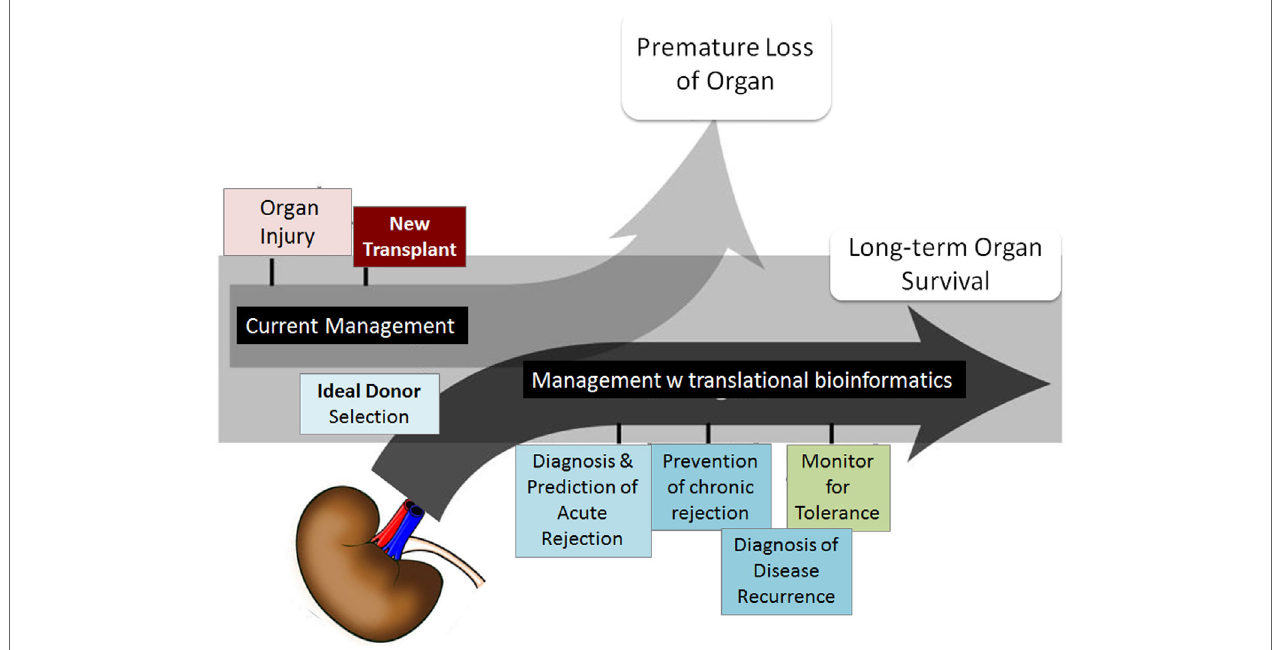
FiGURe 1 | Transplant fields require computations . The boxes show the areas of investigation needed by translational computational methods to advance organ transplant management. Figure adapted from Ref.